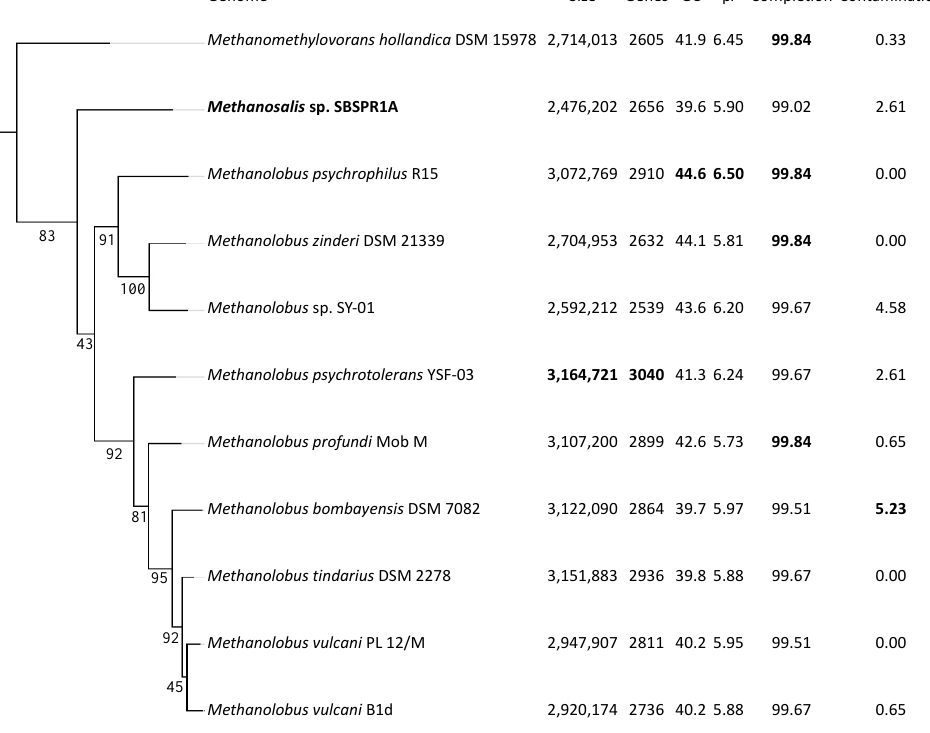
Figure 1. RAxML phylogenetic tree of the 11 genomes in this study using a concatenated alignment of 122 single copy archaeal genes and the PROTGAMMALG model of amino acid substitution. Branch labels show the bootstrap support, calculated with 1000 bootstraps. Also shown are the genome size, number of protein-coding genes, % G + C content, mean isoelectric point of protein-coding genes (p I ), and percent completeness and contamination estimates from CheckM. The greatest values in each column are bolded. The tree is rooted with Nitrosopumilus adriaticus (Thaumarchaeota) as an outgroup (not shown).